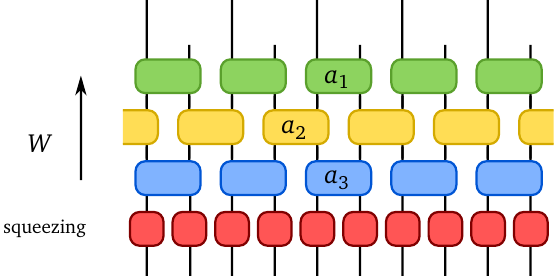
Figure 3: Decomposition of a single layer of the entanglement renormalization